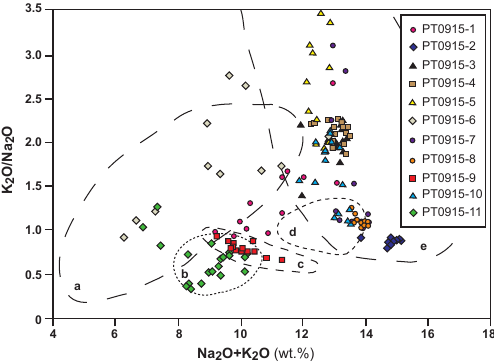
Fig. 6. Na 2 O+K 2 O vs. K 2 O/Na 2 O diagram (modified after Keller et al., 1978; Wulf, 2001; Calanchi and Dineli, 2008), showing the geochemical discrimination between the different volcanic provinces of Italy (dotted lines): (a) Aeolian Island, (b) Mount Etna, (c) Pantelleria Island, (d) Ischia Island, (e) Campanian Area (includ- ing Campi Flegrei and Somma Vesuvius) and investigated tephras and cryptotephras of core Co1215 from Lake